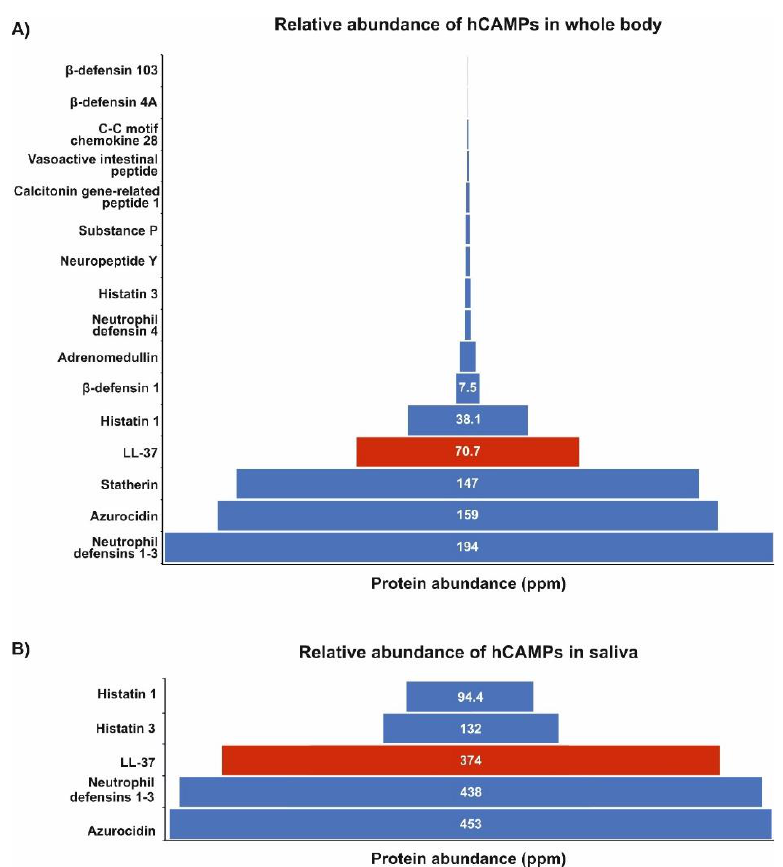
Figure 3. Relative abundance of CAMPs, including LL-37 (highlighted in red), in whole organism (panel A ) and saliva (panel B ). The data were obtained from PAXdb (Protein Abundance Database; https://pax-db.org/) [33] and are based on a mass-spectrometry-based study of the human proteome by Wilhelm et al. (2014) [33] ; parts-per-million (ppm) values represent the abundance of each pro- tein with reference to the entire expressed proteome, i.e., each protein entity is enumerated relative to all other protein molecules in the sample.